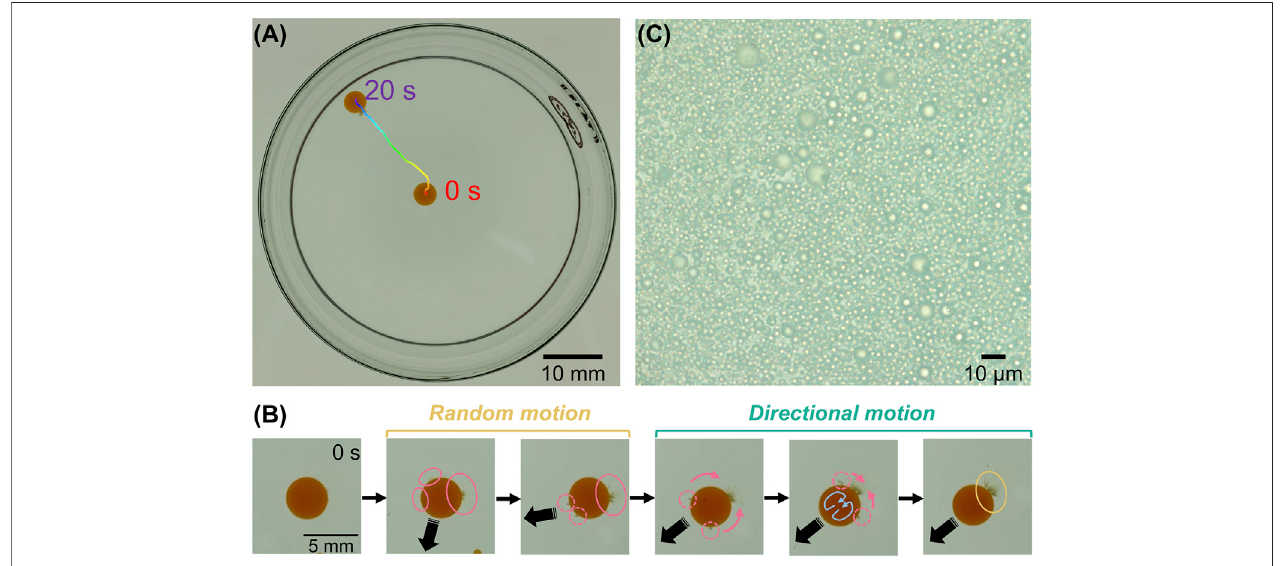
FIGURE 1 | (A) Top-view image illustrating the self-propelled locomotion of a droplet for 20 s ([DMPC] = 1.0 mg/ml, [I 2 ] = 10 mM, and [TSAC] = 1.0 mM). (B) Successivesnapshotsofaself-propelleddropletunderthesameconditionasin (A) .Pinkandyellowcirclesshowejectionpointsofaggregatesatthebeginningand fi nal stages, respectively. Blue arrows represent Marangoni convection inside the droplet. (C) Enlarged image of an ejected